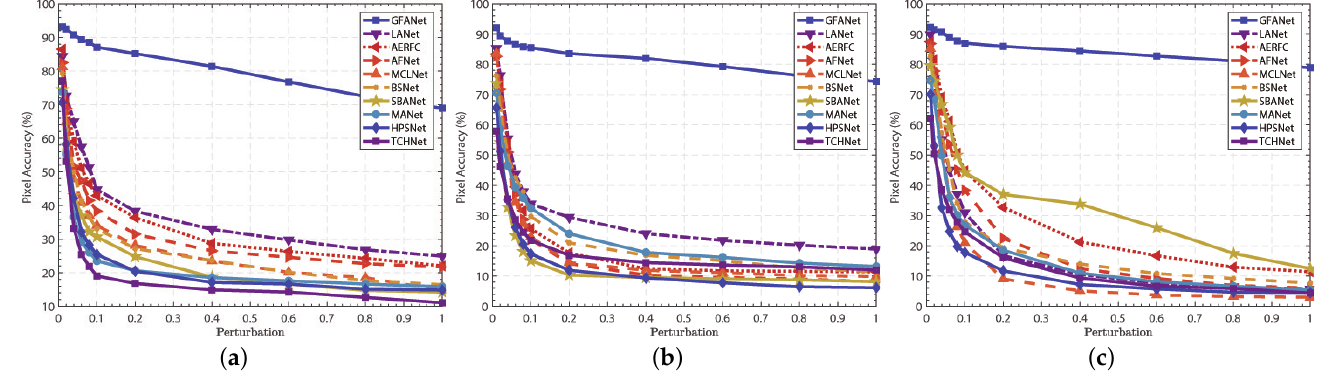
Figure 11. The pixel accuracy of different methods on the adversarial example test set with differ- ent perturbation values. ( a ) UAVid dataset [2]. ( b ) Semantic Drone dataset [70]. ( c ) Aeroscapes dataset [71].